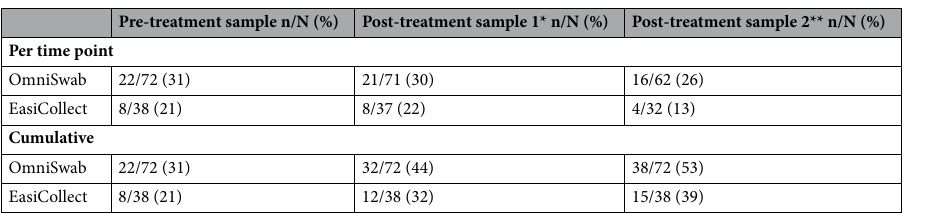
Table 3. Mycobacterium tuberculosis detection yield per time point and cumulatively for the 110 patients who had samples collected with either the OmniSwab or EasiCollect device. *Post-treatment sample 1 was typically collected 4 days following treatment initiation. **Post-treatment sample 1 was typically collected 7 days following treatment initiation.